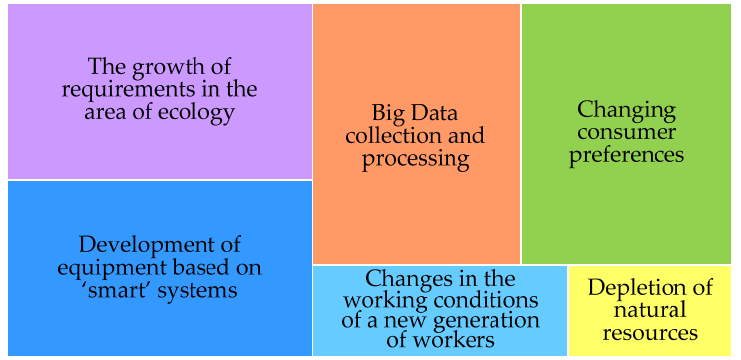
Figure 8. A refined image of the future of Kazakhstan’s oil and gas